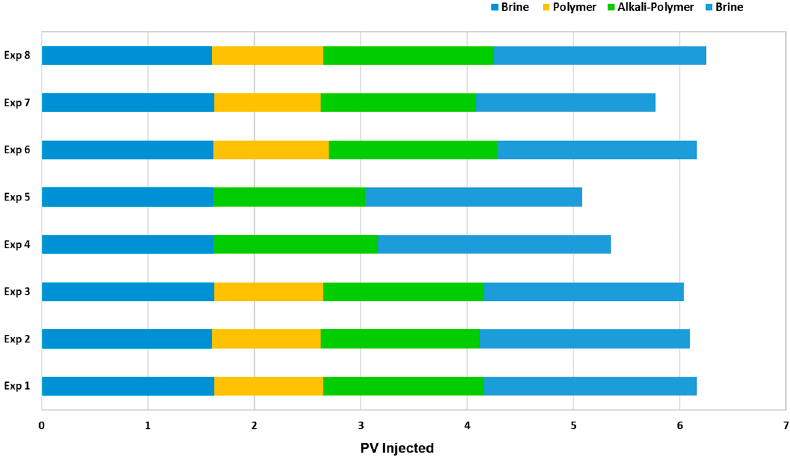
Figure 3. Injection sequences for the different core flood experiments utilized in this